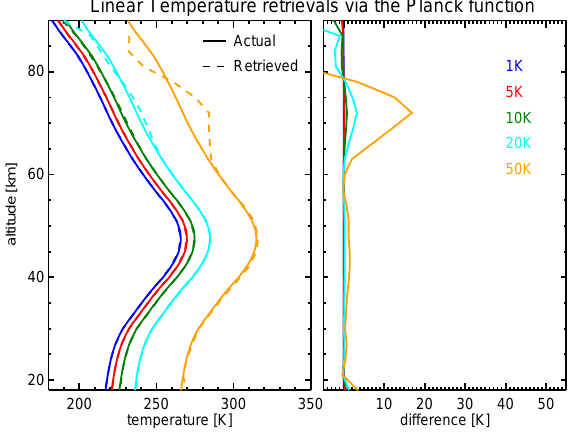
Fig. 4. Linearly retrieved temperature via the Planck function for different increments of the entire temperature profile (left) and absolute difference between the actual and retrieved values (right).